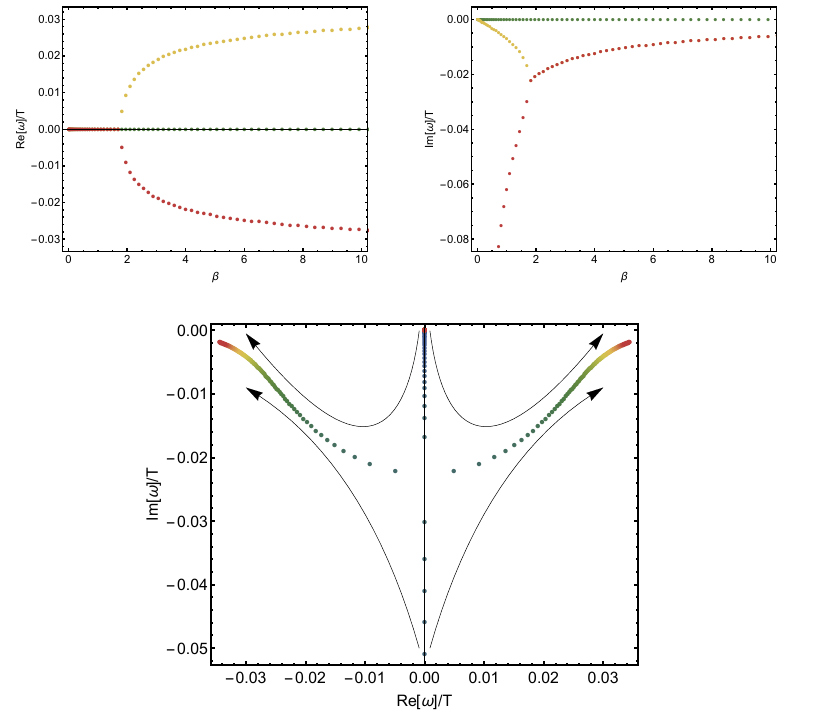
Figure 21 . The two lowest mode in the longitudinal sector for m=T = 0 : 1 ; (cid:11) = 0 : 01 and increasing the parameter (cid:12) from zero to large values. The collision of the poles and the presence of the light pseudo-phonons are evident. Also, the damping of the crystal di(cid:11)usion mode is consistent with zero. The arrows in the bottom panel guide the eyes in the direction of increasing (cid:12)